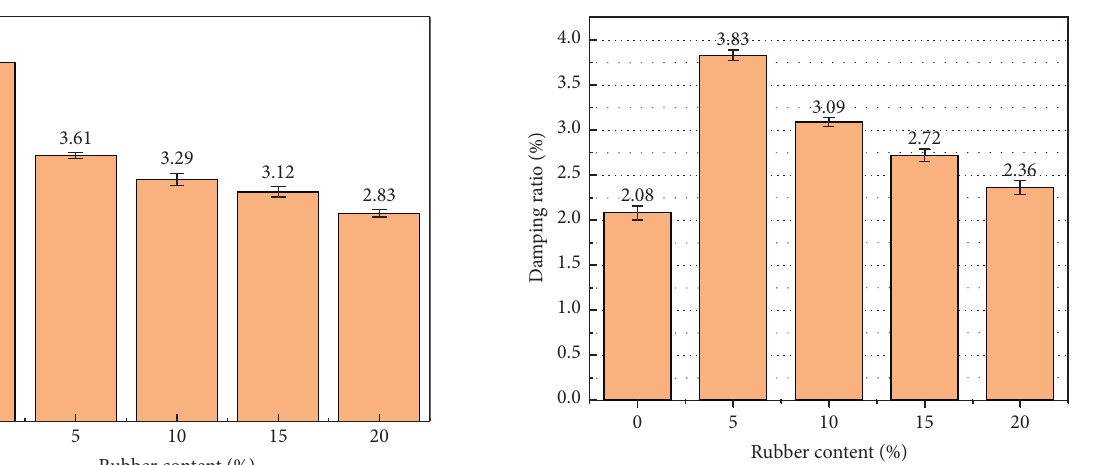
Figure 8: 28-day flexural strength of fiber concrete with different rubber contents.